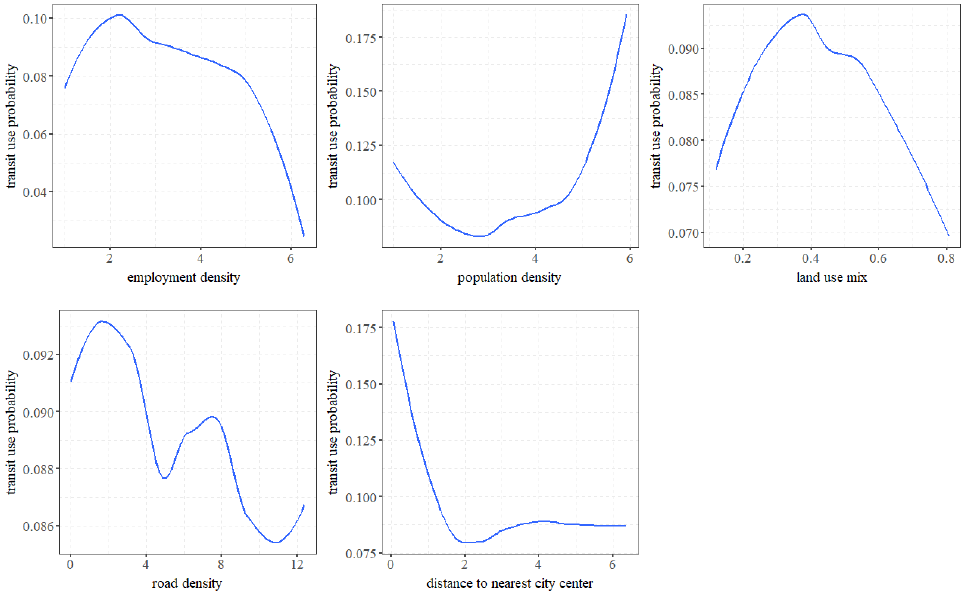
Figure A2. Nonlinear effects of other built environment features on transit use in suburban areas.